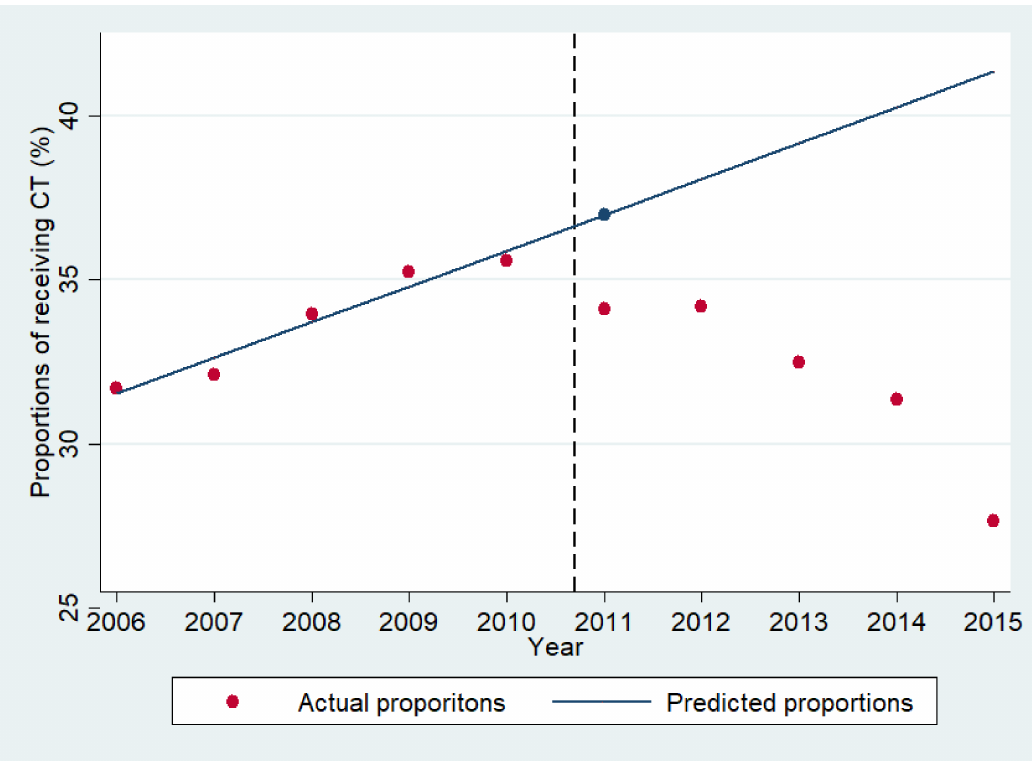
Figure 1. Trends in the proportions of children with mild head injuries undergoing CT examinations from 2006 to 2015. Red circles indicate the actual proportions of patients undergoing CT. The blue circle indicates the predicted proportion of patients undergoing CT in 2011. The blue line indicates the extrapolated prediction if the 2006 – 2010 trend in proportions of patients undergoing CT had continued. The black-dashed line indicates the month of the Fukushima Daiichi Nuclear Power Plant accident (March